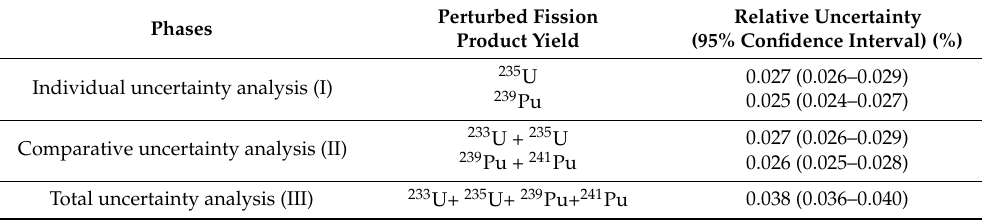
Table 3. Fission fraction and nuclide amount for each fissile at burnup equilibrium core.